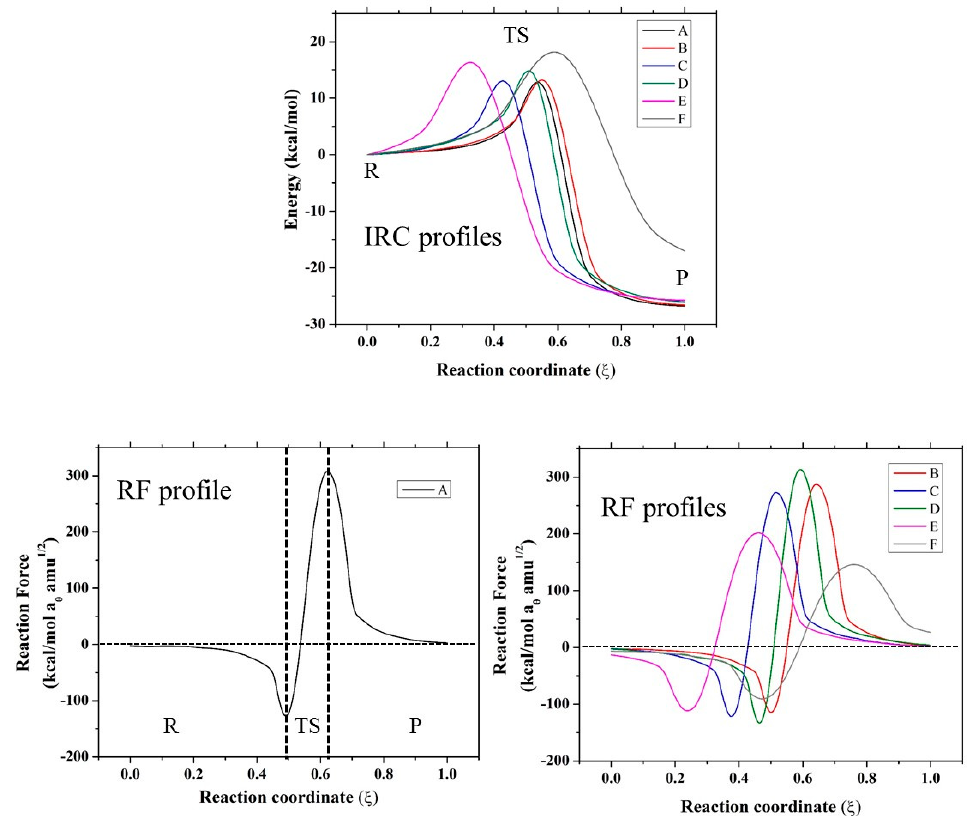
Figure 1. Intrinsic coordinate path reactions (IRC) and reaction force (RF) profiles of S N2 mechanism for all evaluated compounds.